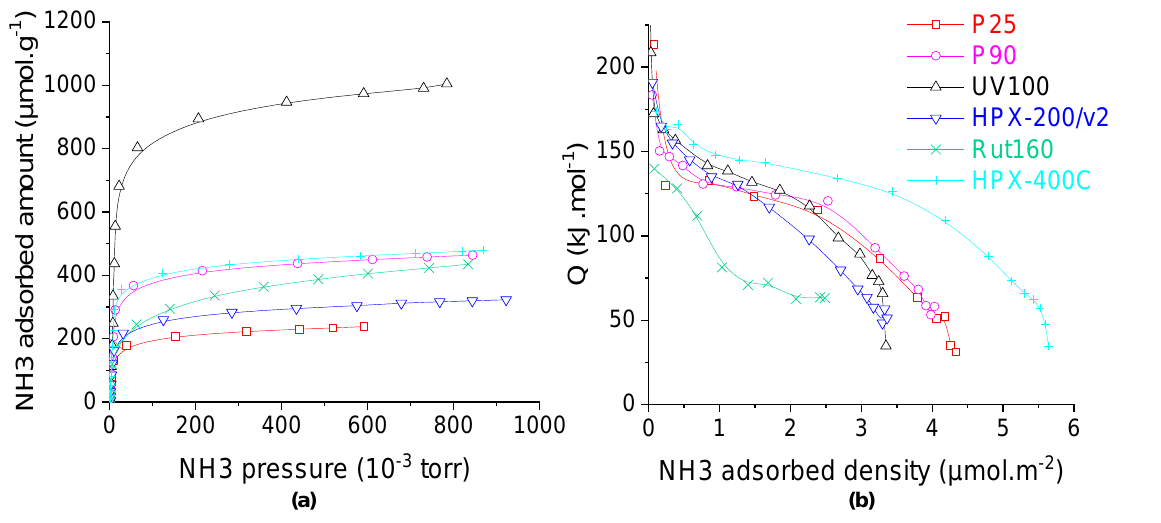
Figure 4. Ammonia adsorption on the TiO 2 samples: ( a ) isotherms and ( b ) calorimetric curves. Conditions: TiO 2 samples pre-treated at 150 °C under secondary vacuum for 5 h, NH 3 adsorption performed at 80 °C.